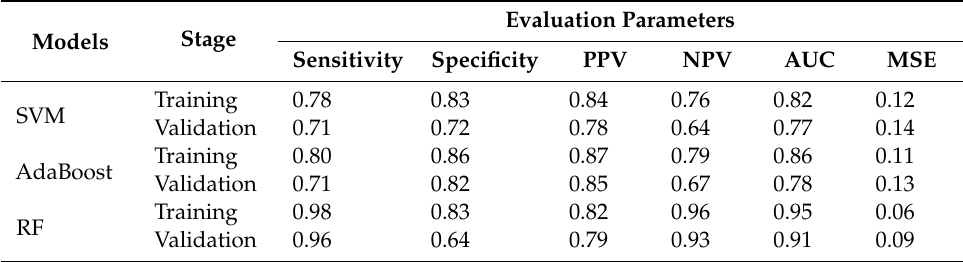
Table 4. The calculated ROC parameters and mean square error (MSE) in each model.